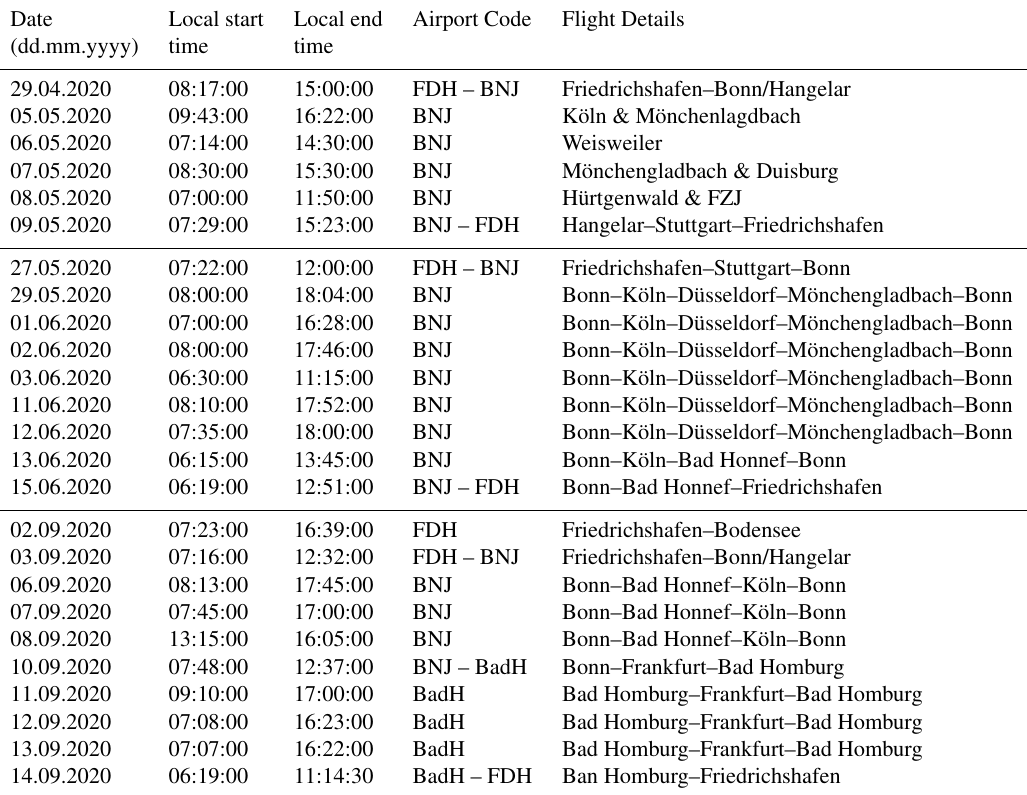
Table 1. Zeppelin flight